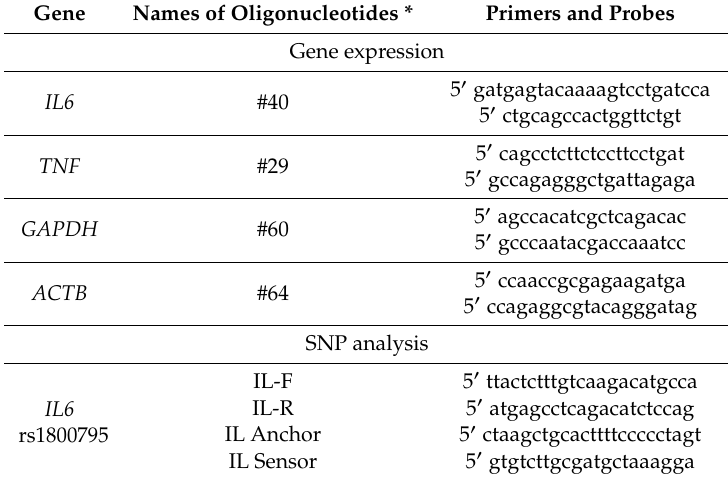
Table 2. Probes and primers used for gene expression and genotyping analysis. Gene Names of Oligonucleotides